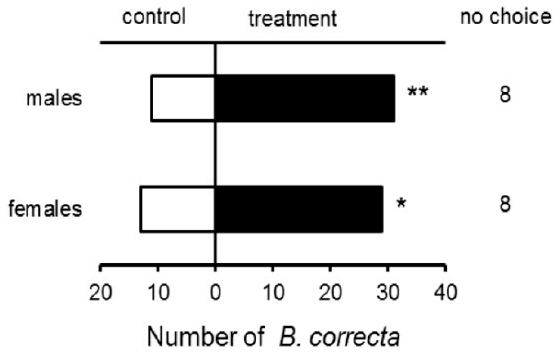
Figure 1. Responses of male and female B. correcta to rectal gland extracts of 13-d-old virgin females vs. hexane (control), where 50 flies were tested; * indicates significant differences at p < 0.05 and ** indicates p < 0.01, respectively, per chi-square test and Yates’s correction.